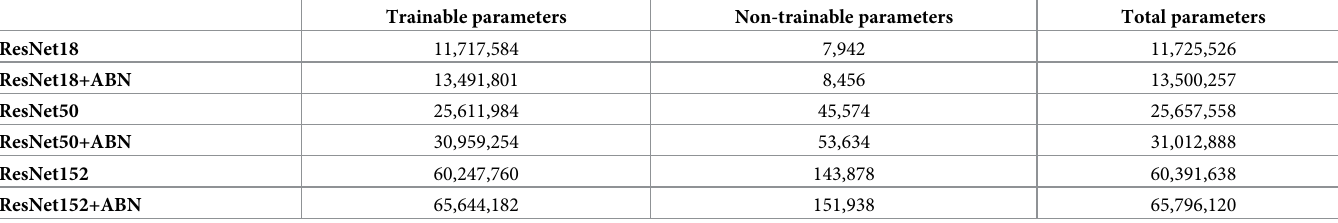
Table 3. Number of parameters for simple ResNet model and ResNet with ABN